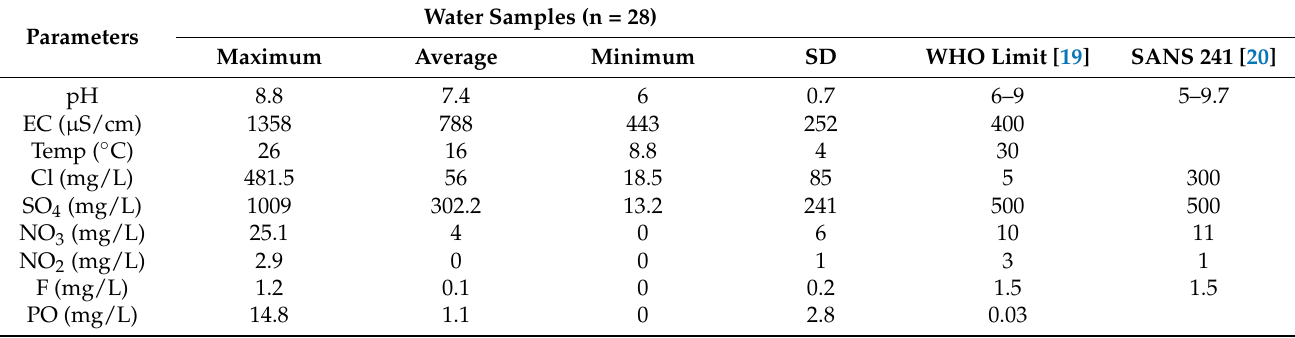
Table 1. Rietspruit water chemistry.